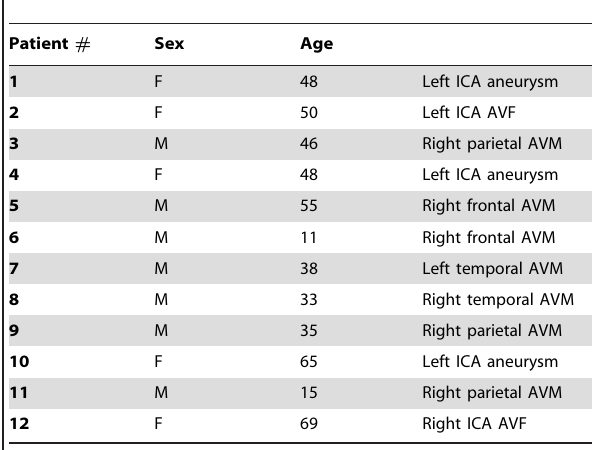
Table 1. The clinical patient